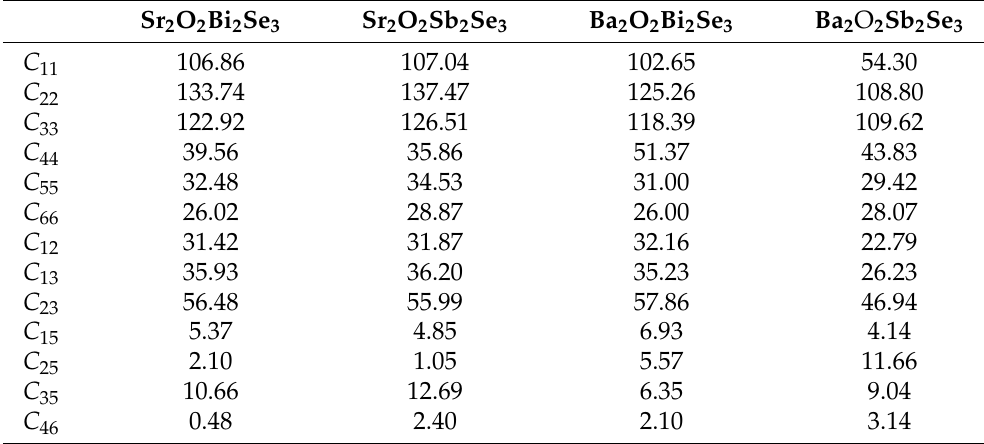
Table 2. The calculated elastic constants of the A 2 O 2 B 2 Se 3 (A = Sr, Ba and B = Bi, Sb) compounds in the units of